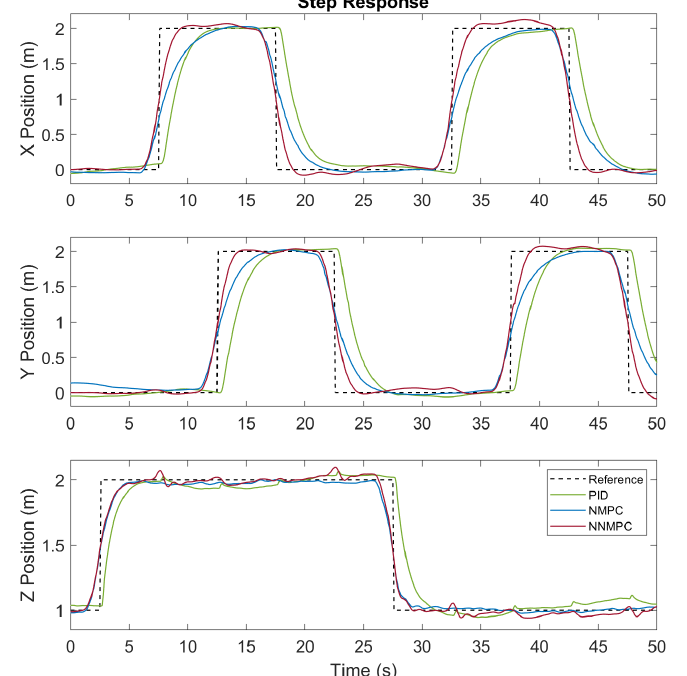
Figure 6. Step trajectory Tracking results for PID, NMPC, and NNMPC controllers in three axes from